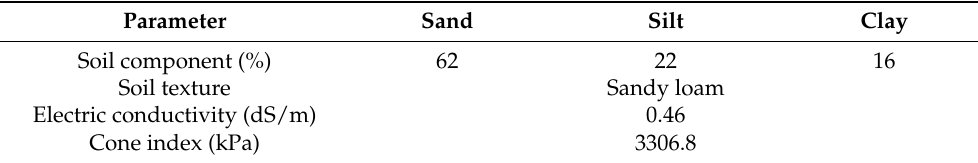
Table 4. Soil analysis of the experimental